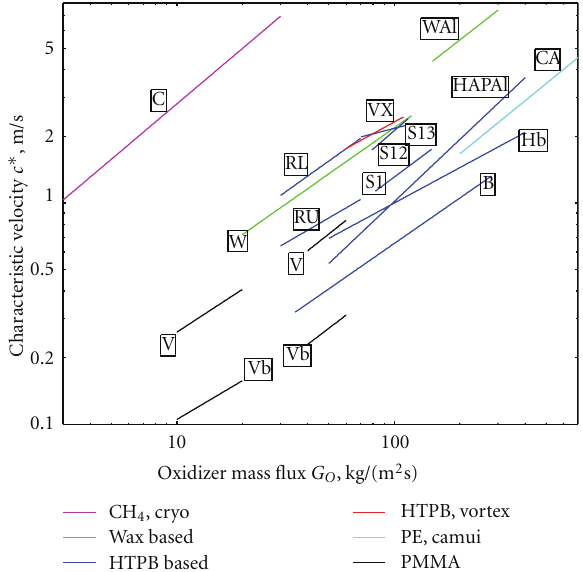
Figure 4: Regression rate for di ff erent systems and GOX/fuel combinations (see legend in Table